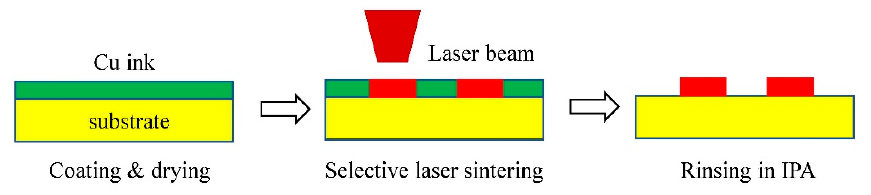
Figure 8. SLS printed micro PCB (IPA: isopropyl alcohol).